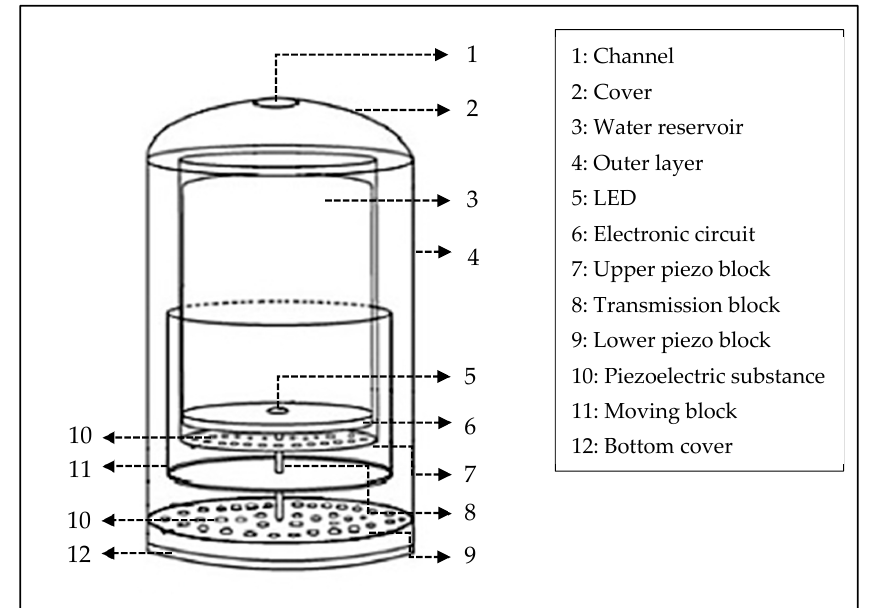
Figure 1. Illustration of the main components [18].